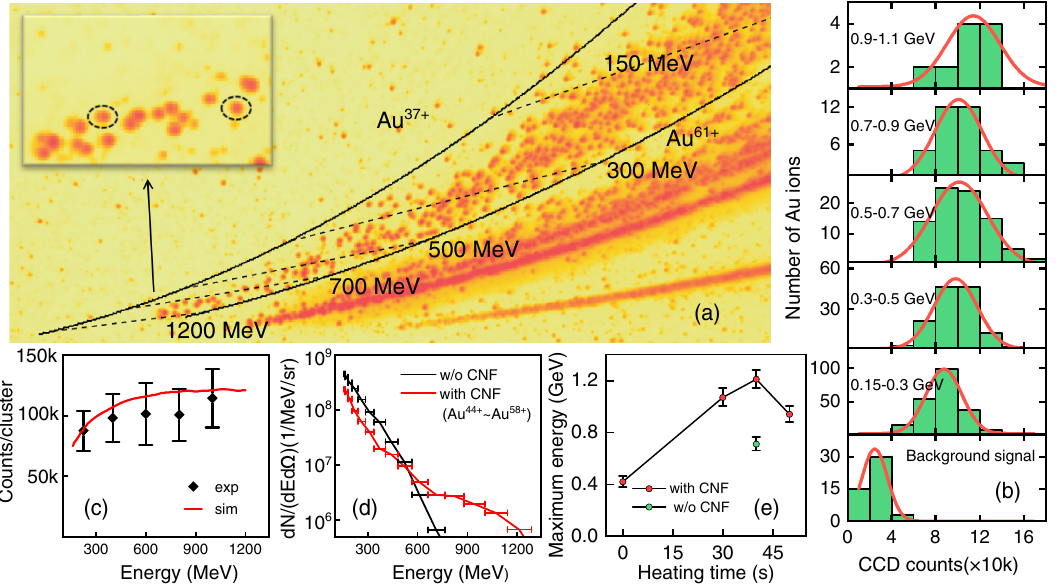
FIG. 3. (a) Schematic of the statistics of single-ion events. The solid lines represent the parabolas of Au 37 þ and Au 61 þ , and the dashed lines represent the constant energy lines. The inset shows the zoomed clusters of ion signals. (b) Statistical results of single-ion events. The red lines are the Gaussian fitting curves. (c) Responses for Au ions. (d) Energy spectra of Au ions. (e) Maximum energy of Au ions without heating and by varying the heating